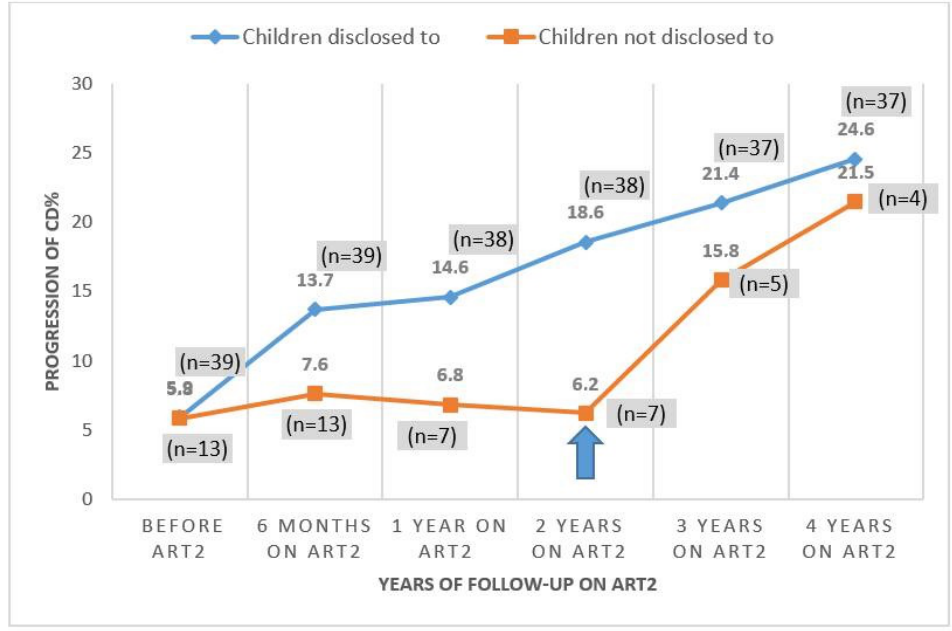
Figure 2. Evolution of the CD4% in the two groups (children immediately disclosed to (blue) vs. children not immediately disclosed to (orange) then disclosed to after 2 years (blue arrow)) during 4 years on second-line ART.